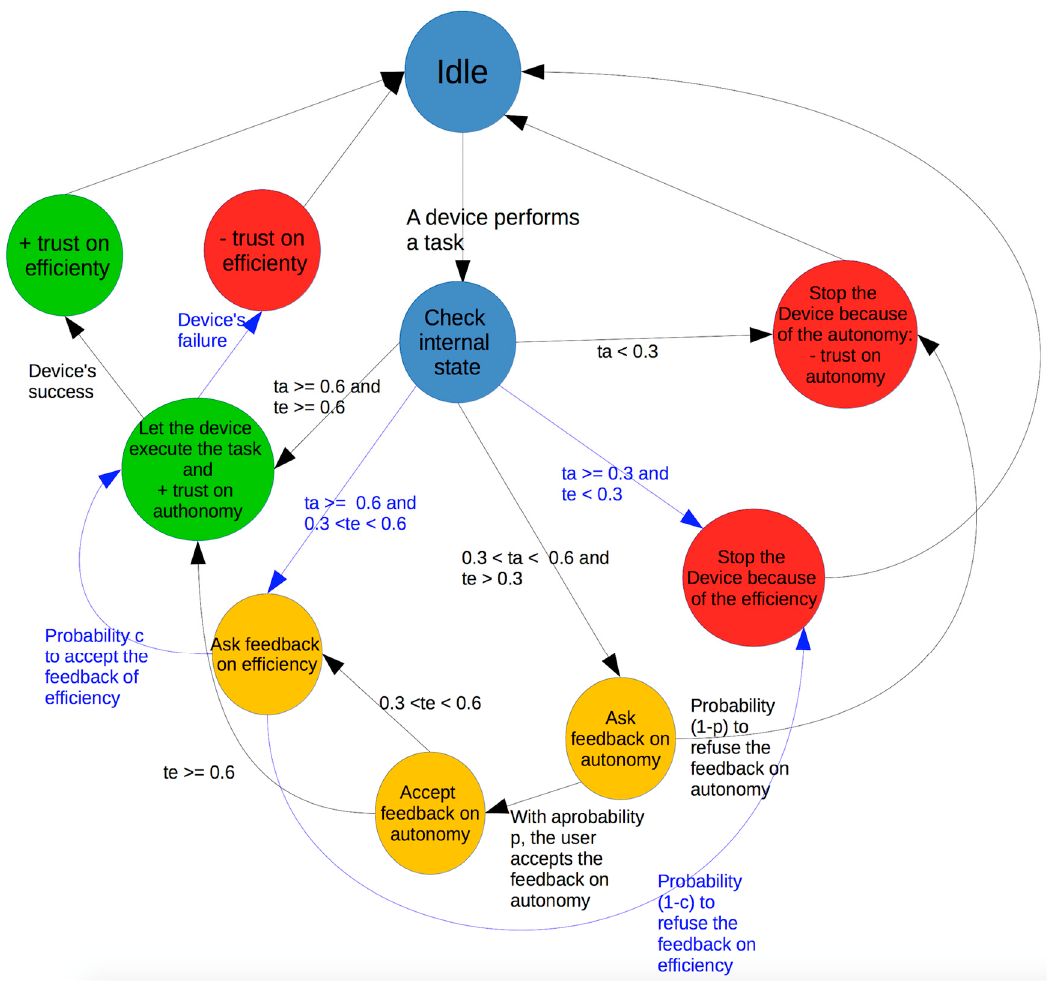
Figure 1. Graph representing the user behavior according to its internal state.